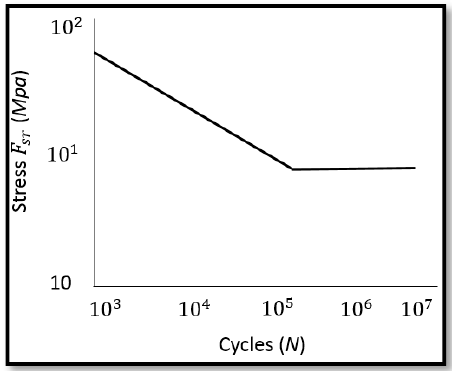
Figure 7. Allowable stress range for cyclically applied load (fatigue) for welded joint category B. Table 7. Summary fatigue life welded joint S-N